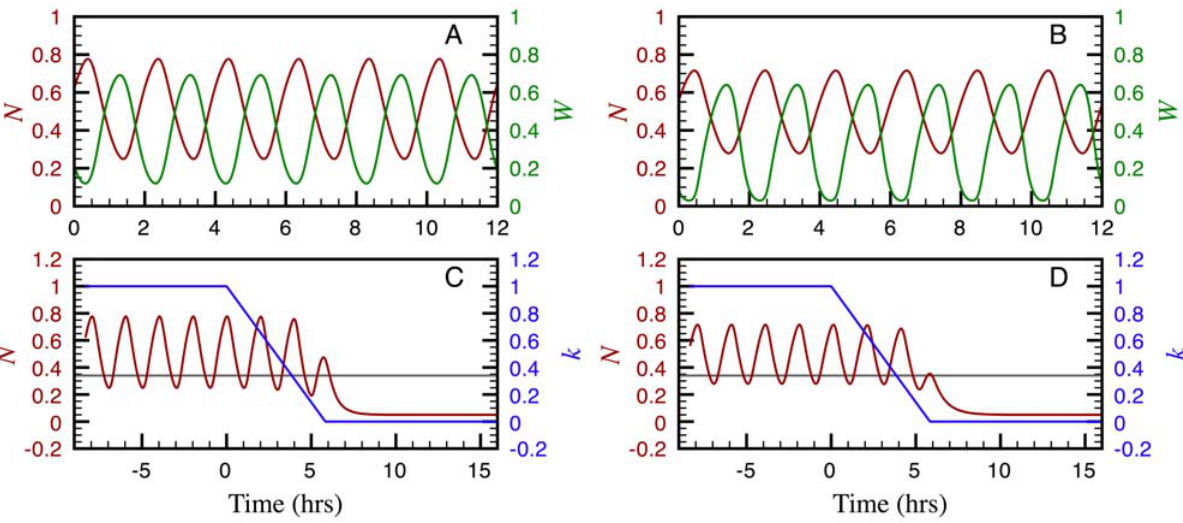
Figure 2. A and B, plots of Nvs.t and Wvs.t resulting from the numerical solution, with k =1, of the equations corresponding to the networks in Figures 1A and 1B, respectively. C and D, plots of N vs. t and k vs. t as k decays, for the models corresponding to the networks in Figures 1A and 1B. The time at which the cell leaves the TB and k starts decreasing is t =0. The horizontal grey lines represent the k 9 bifurcation value below which the oscillations are arrested. All other parameters were set to the values estimated in the section on parameter